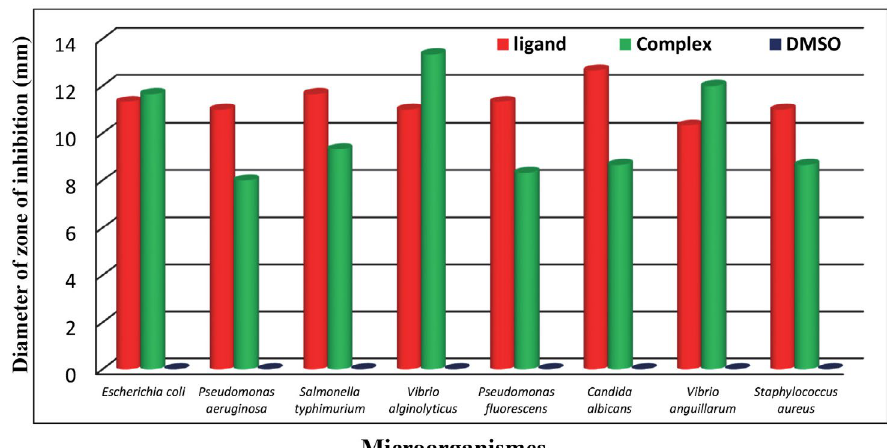
Figure 11. Antibacterial activity spectrum of the